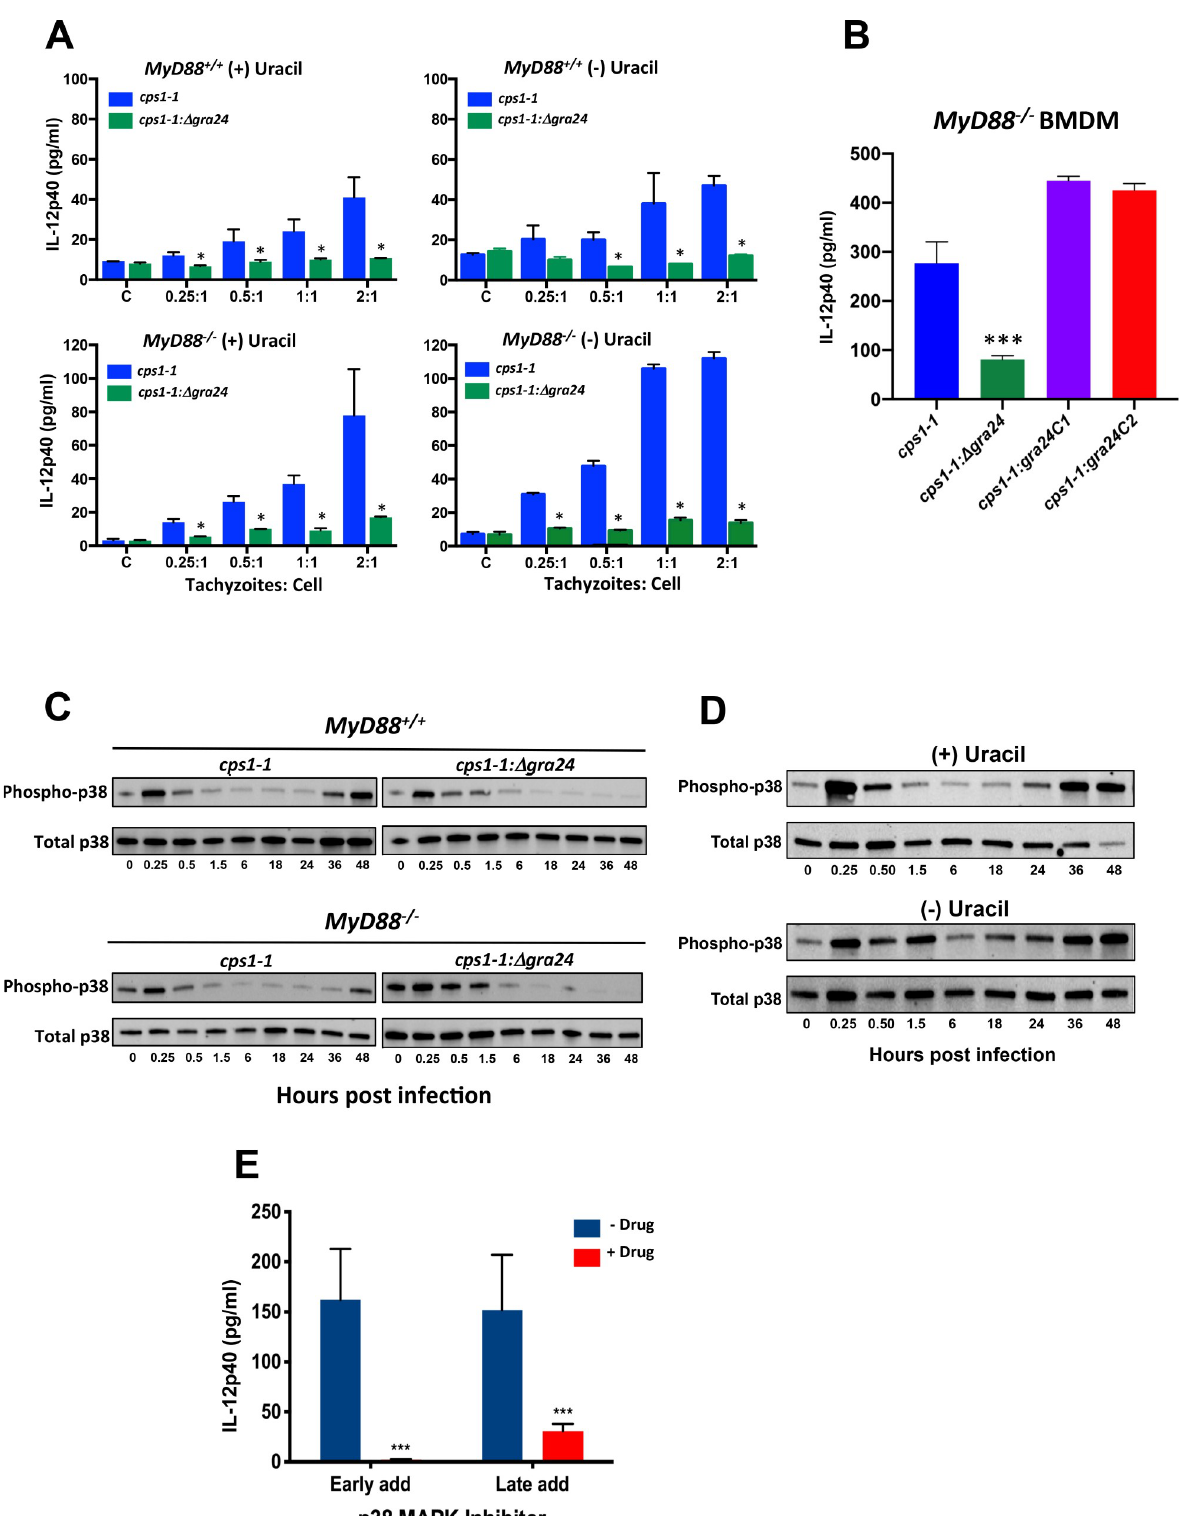
Fig 4. GRA24 controls MyD88-independent p38 MAPK-dependent IL-12 production. ( A ) MyD88 +/+ and MyD88 -/- BMDM were infected with cps1-1 or cps1-1 : Δ gra24 tachyzoites at the indicated parasite to cell ratios. Cultures were initiated with (+) and without (-) exogenous uracil and